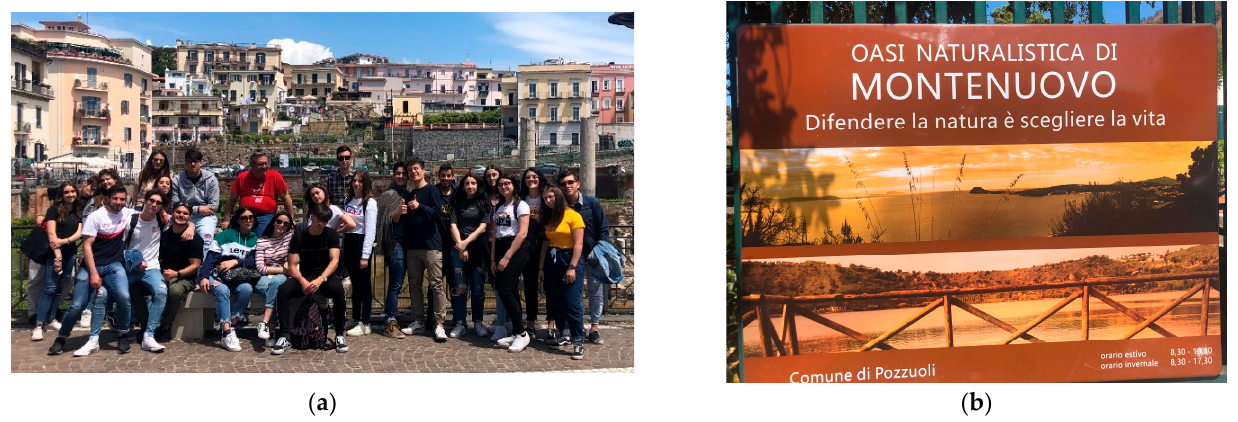
Figure 6. Two moments of the field trip in the Phlegraean Fields (year 2019): ( a ) visit at the ruins of the Temple of Serapis, in the town of Pozzuoli, Napoli Province; ( b ) visit at the naturalistic oasis of Monte Nuovo (a tuff cone born from the last Phlegraean eruption in